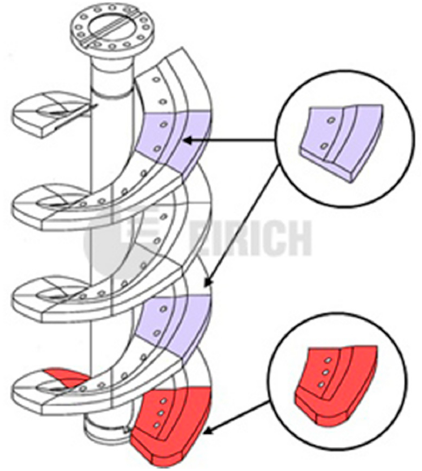
Figure 2. Vertical stirred mill screw liner parts [24].